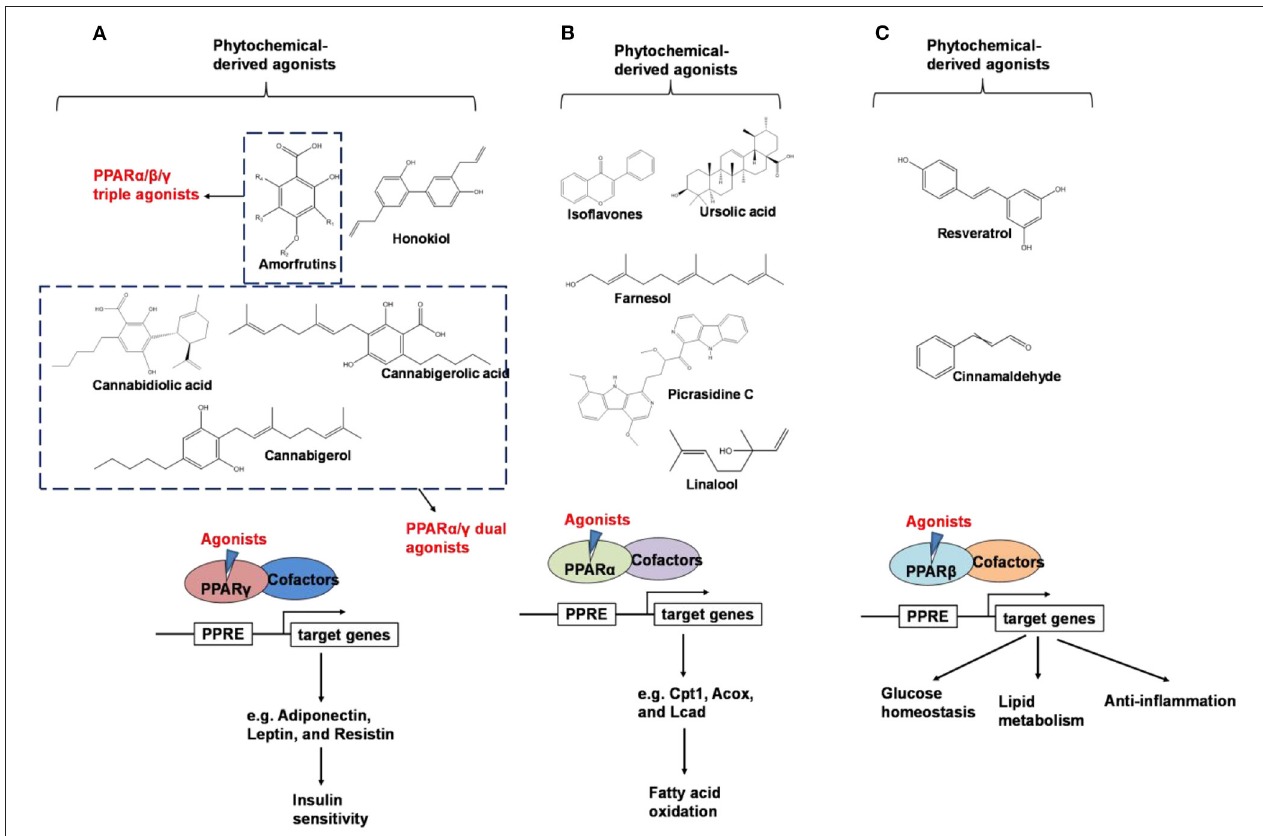
FIGURE 3 | An overview of phytochemical-derived agonists and the biological function of PPARs. (A) Agonists of PPAR γ . (B) Agonists of PPAR α . (C) Agonists of PPAR β .